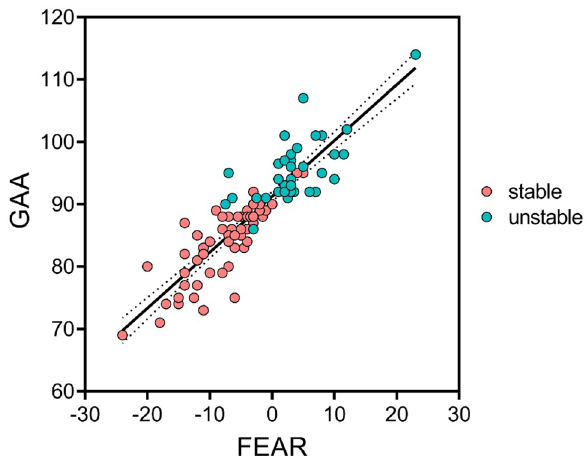
Figure 4. Scatter plot of the relation between GAA and FEAR index for dysplastic hips (LCEA < 25°). Stable hips are displayed in red, unstable hips in green; GAA Gothic Arch Angle, FEAR Index Femoro-Epiphyseal Acetabular Roof Index.